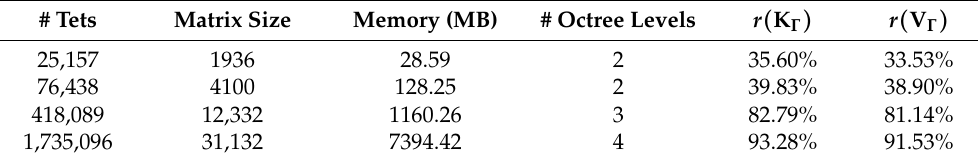
M . Table 3, for the ACA algorithm, and Table 4, for the R-SVD algorithm, show that the compression ratio increases as the number of mesh elements and the number of octree levels increase. Table 3. Compression ratio of single-layer matrix K Γ and double-layer matrix V Γ with ACA. # Tets Matrix Size